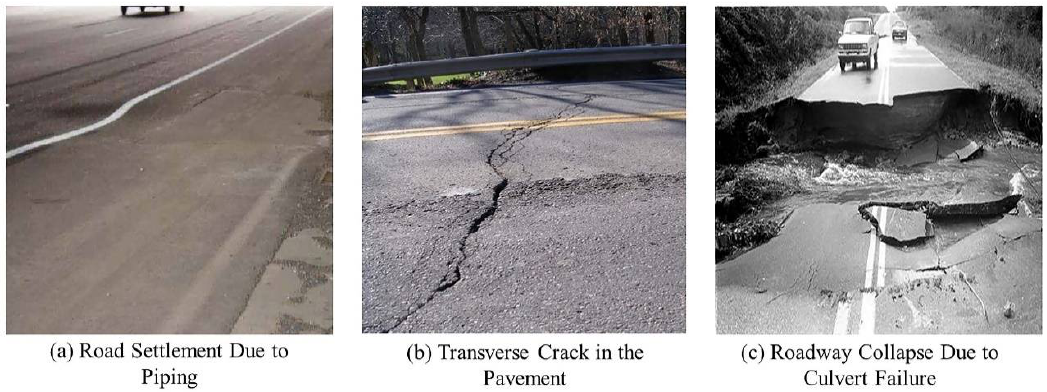
Figure 2. Typical consequences of culvert defects and failures: ( a ) Road Settlement; ( b ) Transverse Pavement Crack; ( c ) Road Collapse.